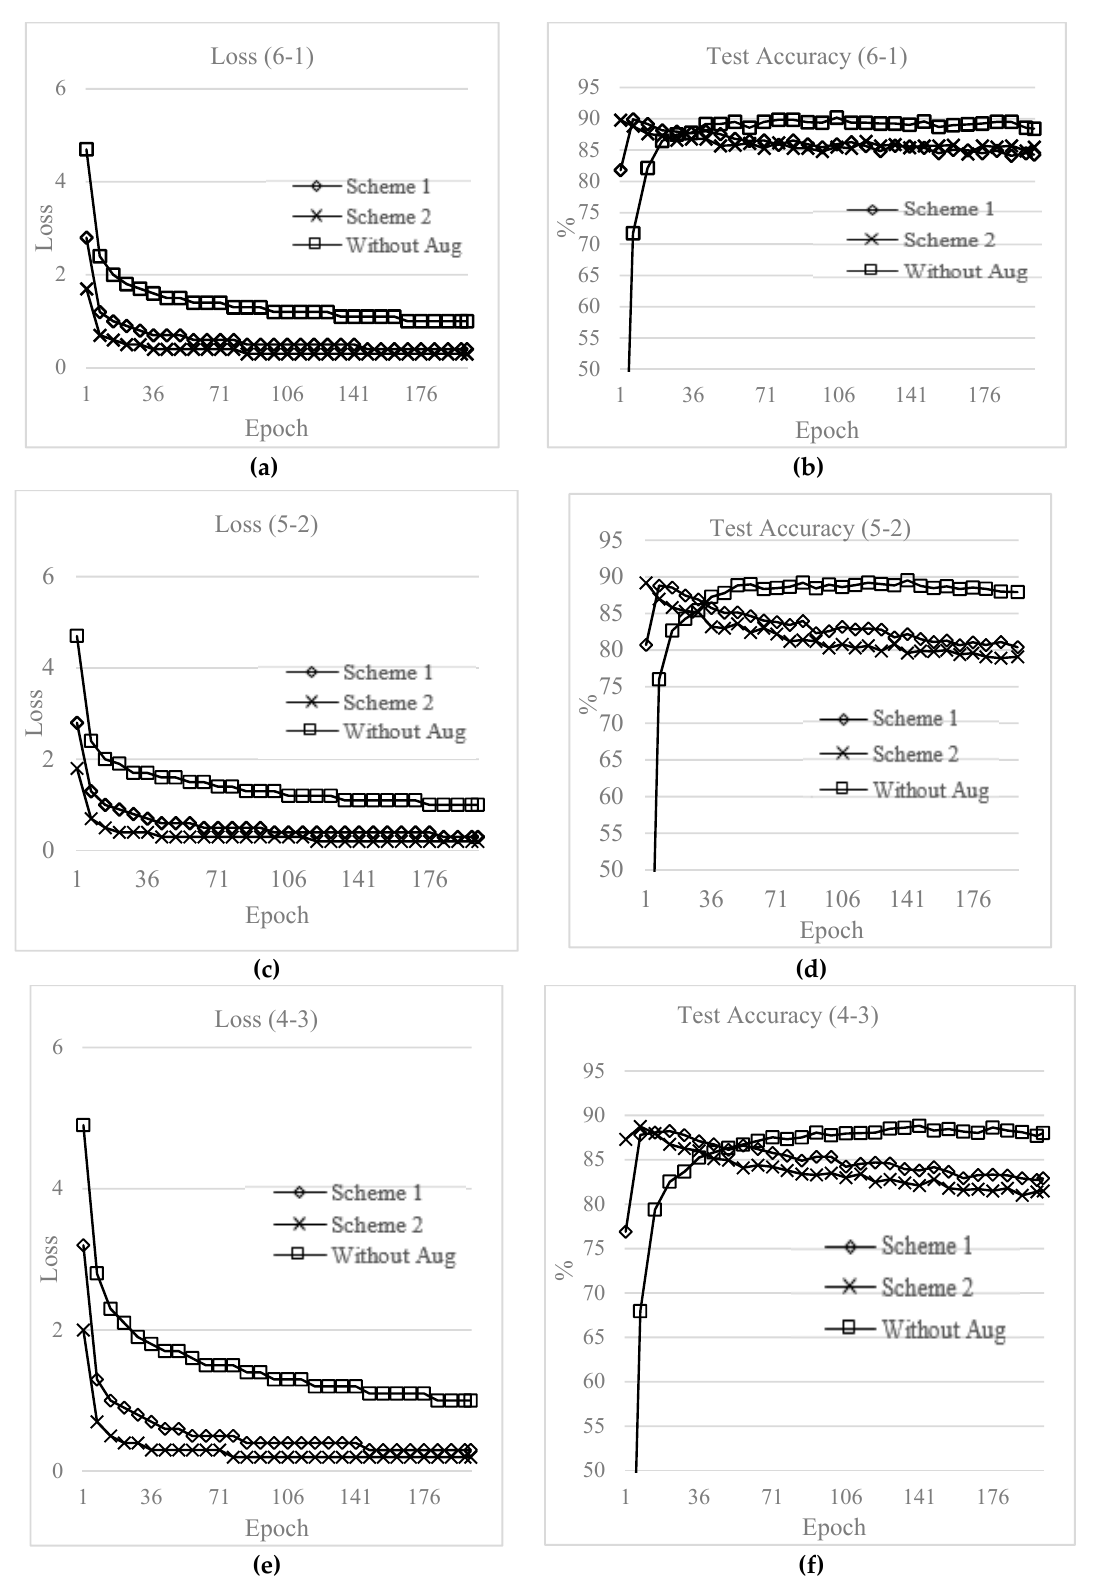
Figure 10. Lab simulation results. ( a , c , e ) Set 1 loss for the three cases. ( b , d , f ) Set 1 test accuracy for the three cases.